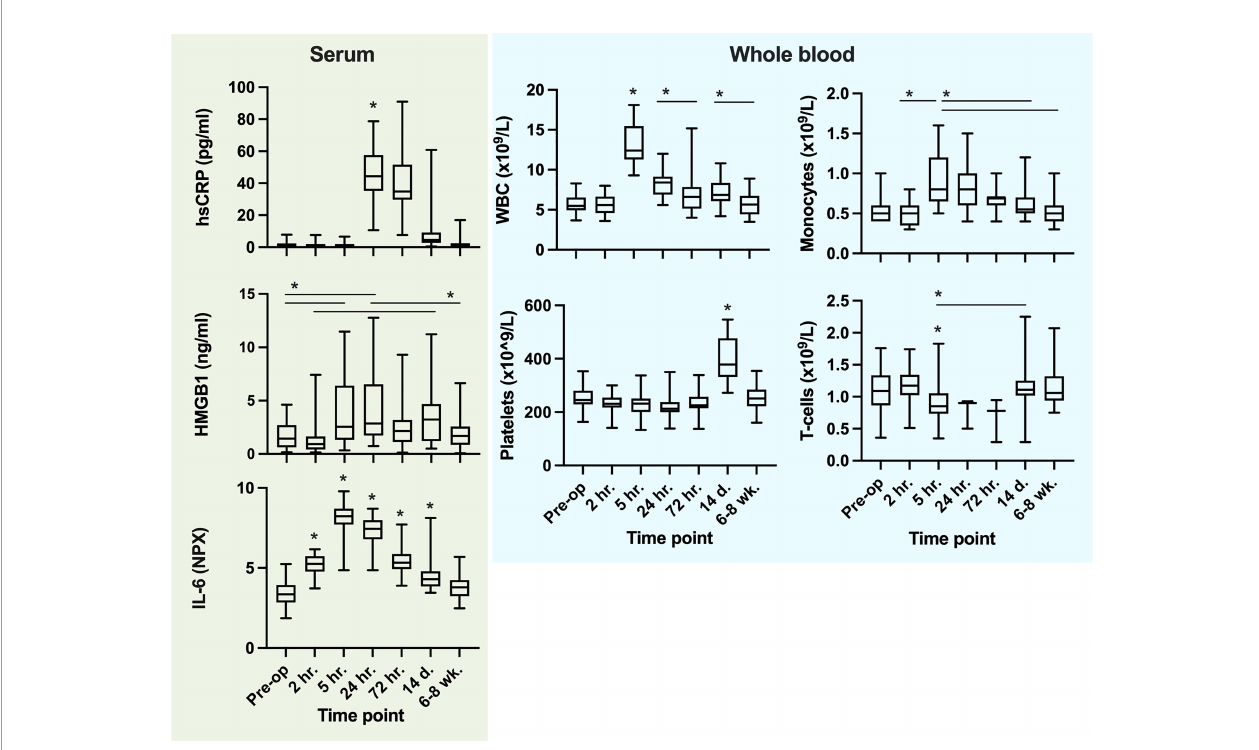
FIGURE 7 | Systemic cytokines, alarmins (serum), cellular systemic trajectories and ex vivo LPS challenge-induced TNF- a release. For Ex vivo LPS challenge, TNF- a (pg/ml) is divided by WBC (x10^9) in order to describe the ‘ reactivity per white blood cell ’ to endotoxin. *P values ≤ 0.05 from the preceding timepoint or interval when present (Tukey´s multiple comparison test). Not all signi fi cant changes between timepoints are